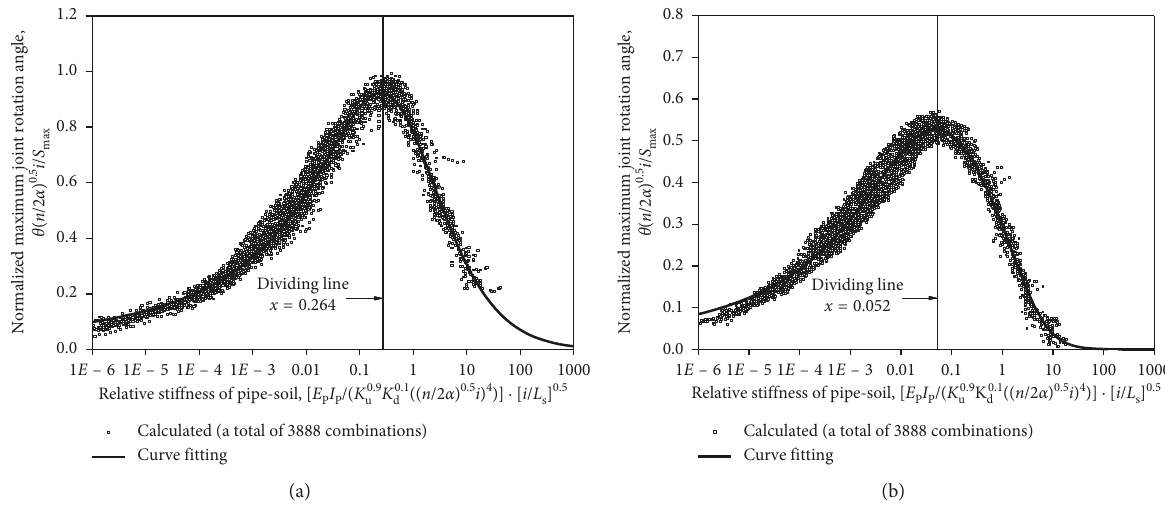
Figure 7: Dimensionless plots of pipe-soil relative stiffness versus normalized maximum joint rotation angle. (a) The maximum ground settlement is located beneath a joint. (b) The maximum ground settlement is located beneath the centre of pipe segment.